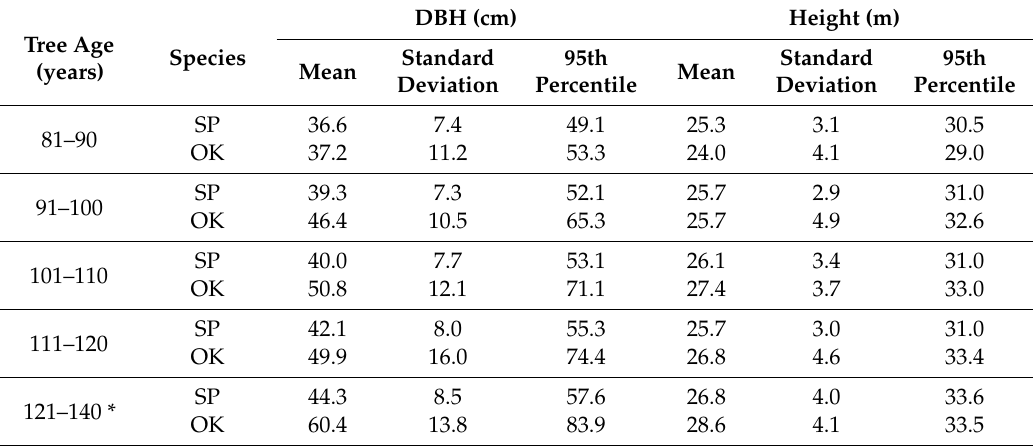
Table 3. Diameter at breast height (DBH) and height of Scots pines and oaks in old stands.